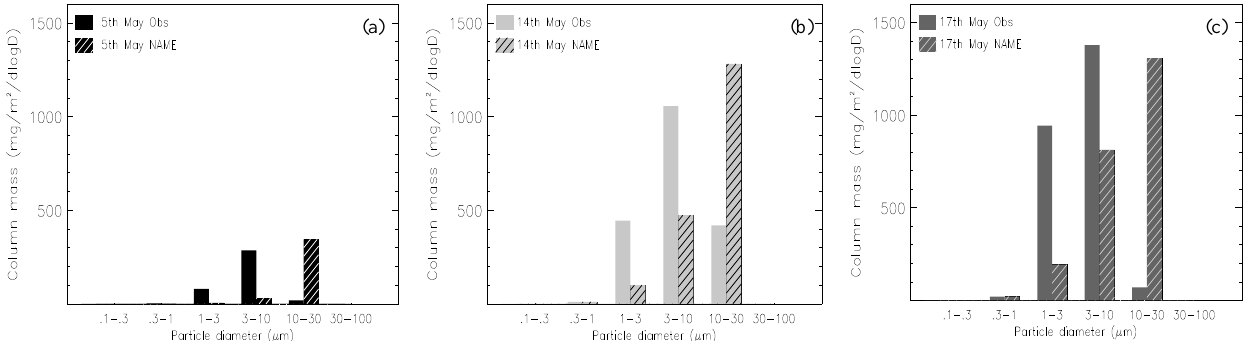
Fig. 4. Binned observed column-integrated mass (solid fill) and NAME column-integrated mass (striped fill) using distal particle size distri- bution 1. (a) 12:00UTC on 5 May, (b) 13:00UTC on 14 May and (c) 15:00UTC on 17 May. Fig. 4. Re-binned observed column integrated mass (solid fill) and NAME column integrated mass (striped fill) using distal particle size distribution 1. (a) 12 UTC on 5th May, (b) 13 UTC on 14th May and (c) 15 UTC on 17th May. layer from the NAME simulation using DPSD 1. The